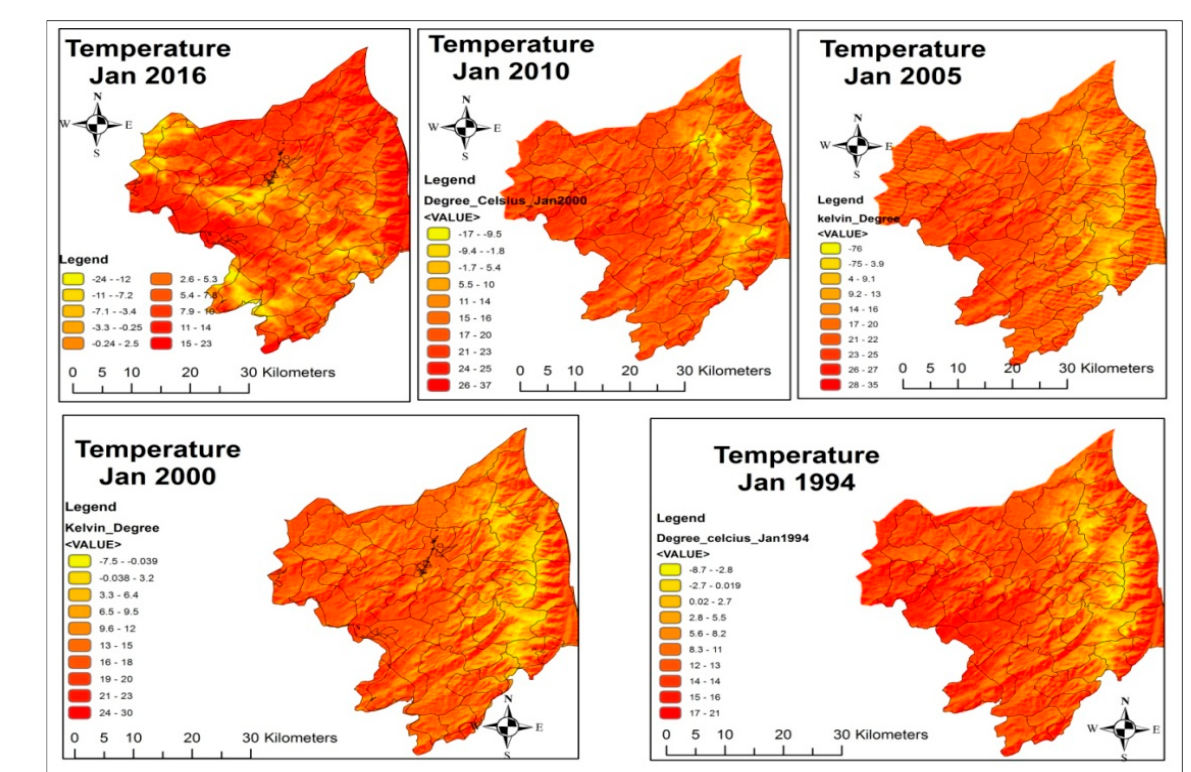
Figure 10. LST of Abbottabad at a Glance from Jan 1990–Jan 2016.